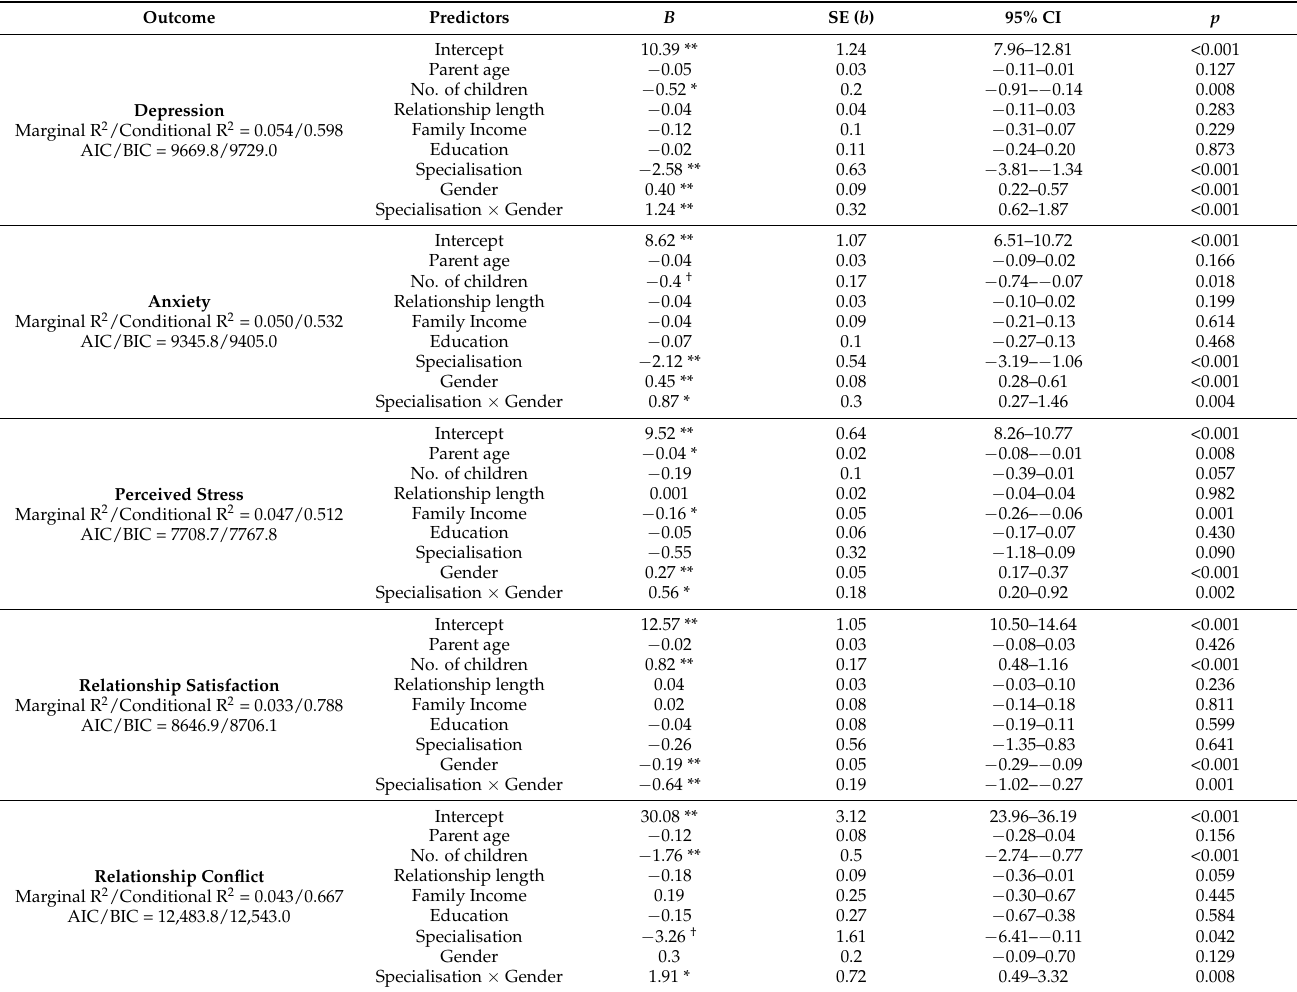
Table 5. Effects of specialisation on Male vs. Female parents’ well-being in mixed-sex